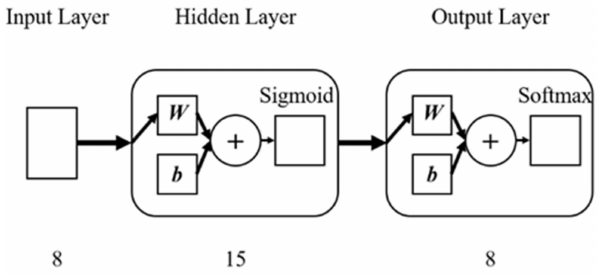
Figure 3. The structure of the ANN. Table 1. The composition of the input